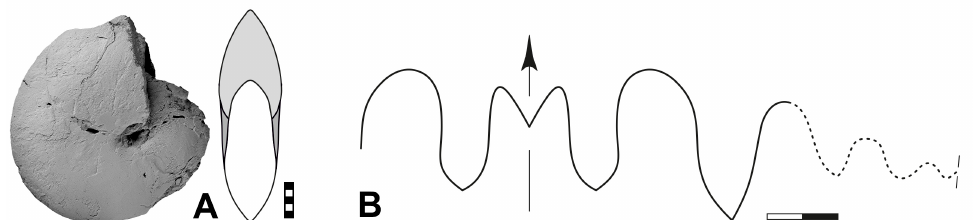
Fig. 15. Taouzites acutus (Matern, 1931). Holotype MB.C.3664 (Etzold 1910 Coll.) from Oberscheld (“Tiefe Grube”). A . Lateral view and dorsal projection. B . Suture line, at dm ca 9 mm, ww = 3.0